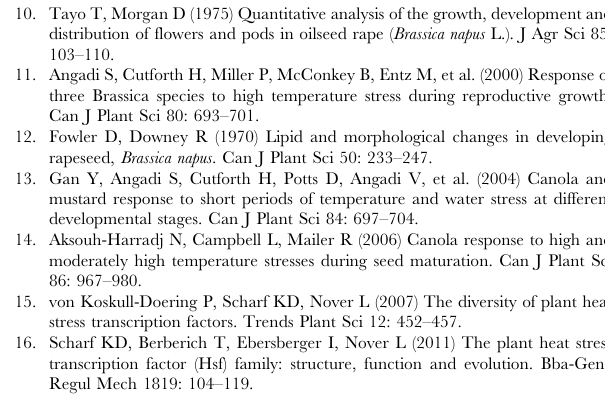
Figure S1 Heat treatment regimen for B. napus during pod development. Plants underwent a stepped heat treatment during the daytime. For microarray analysis, the SW and seeds were sampled from 20 DAF siliques on these plants at 24 h or 48 h after heat stress. Figure S2 RT-PCR analysis of several putative heat- responsive genes during extended recovery time after treatment. The SW and seeds were sampled after recovery times of 24 to 96 h following heat treatment as in Figure S1. H and C indicate heat-stressed and control samples, respectively. Figure S3 Summary of homozygous mutants tested for heat stress phenotypes. The triangles indicate the locations of T-DNA insertions. RNA samples were purified from leaves for h29 , h34 , and h25 ; flowers for h15a, h17 and h26 ; siliques for h23 and roots for h38 . GSPs is the abbreviation for gene specific primers, which are listed in Table S10.